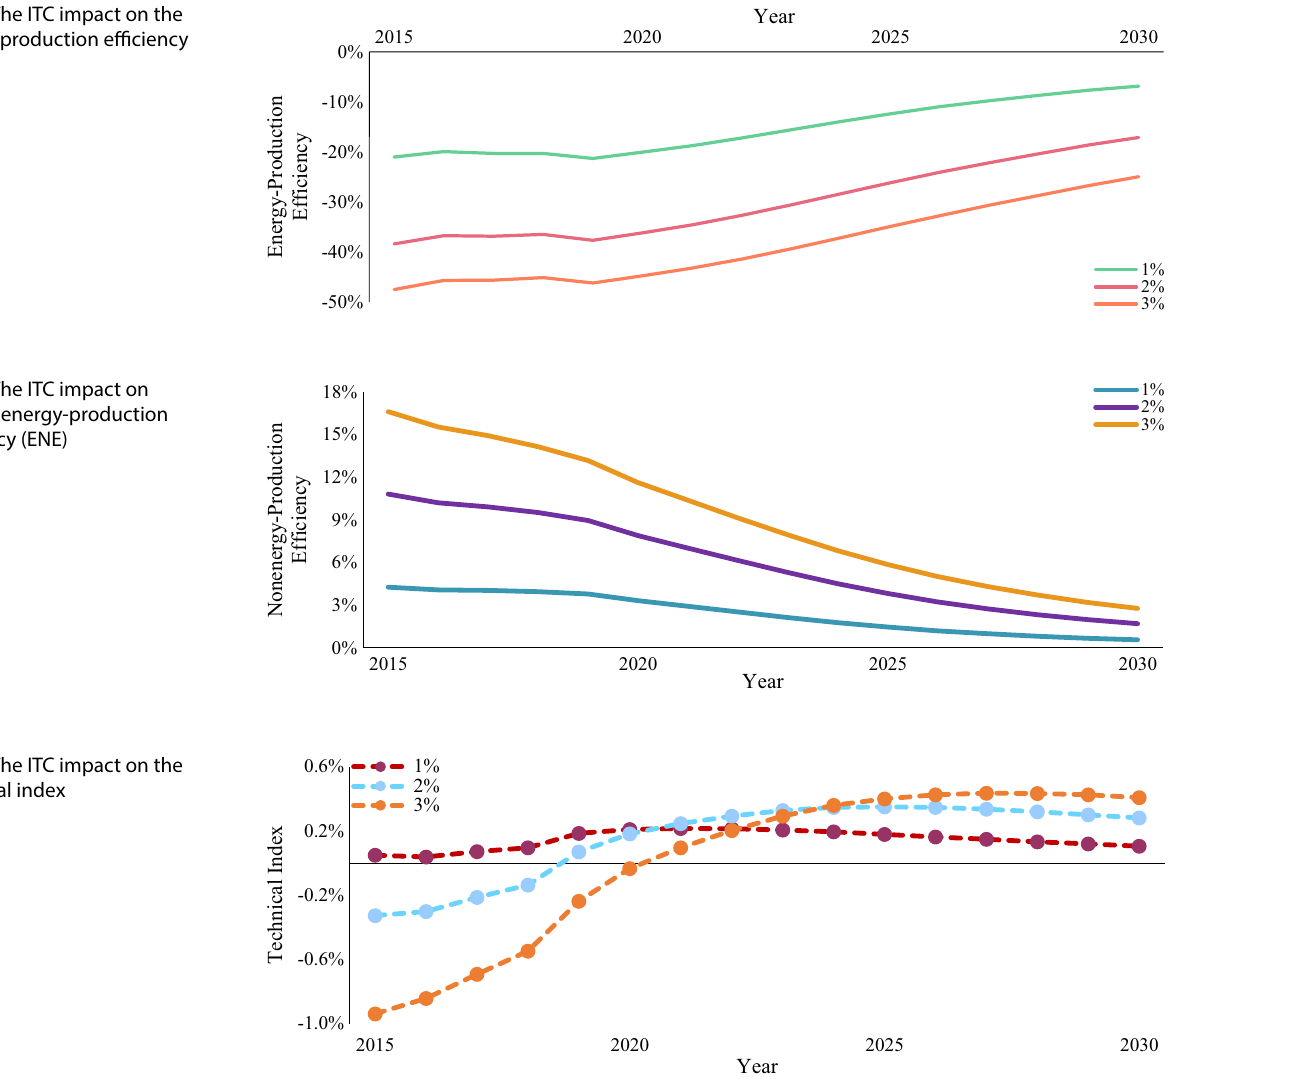
Fig. 4 The ITC impact on the nonenergy-production efficiency (ENE)